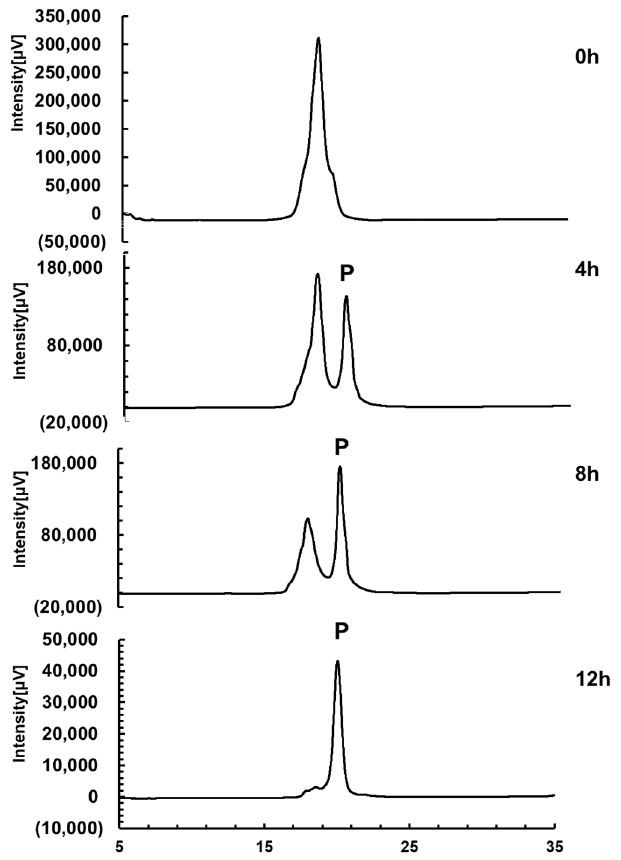
Figure 3. HPLC analyses of the ODN-N reaction with the CuAAC reaction solution at the indicted time where peak “P” is the product.